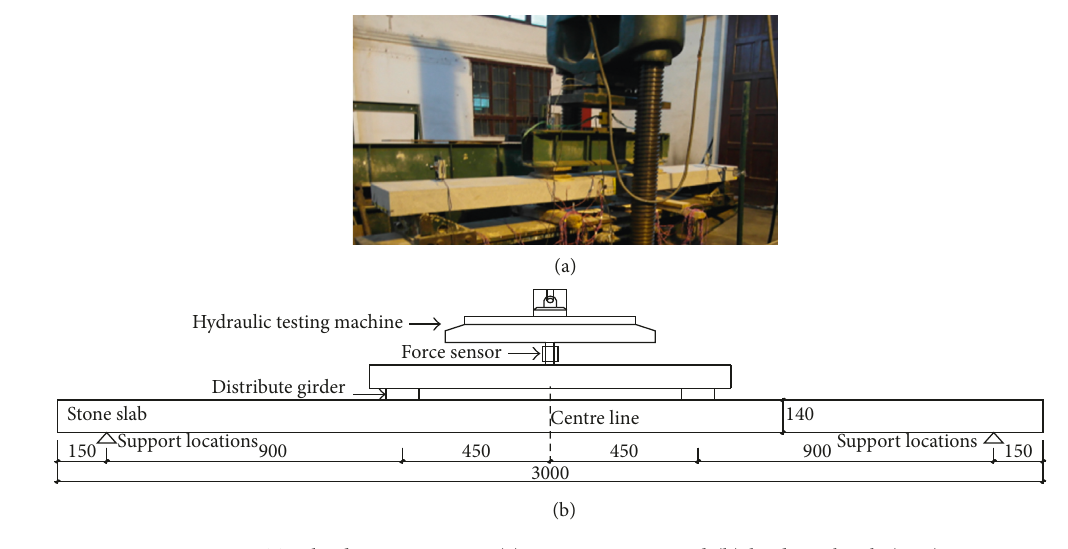
Figure 10: Test loading equipment: (a) test equipment and (b) loading sketch (mm).